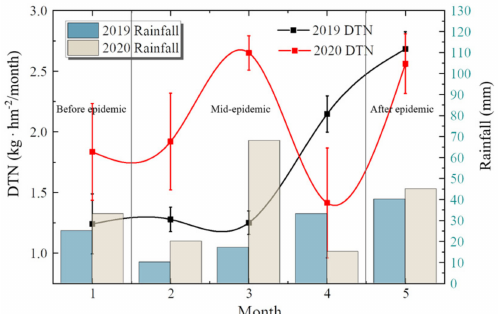
Figure 3. DTN around COVID-19 lockdown.